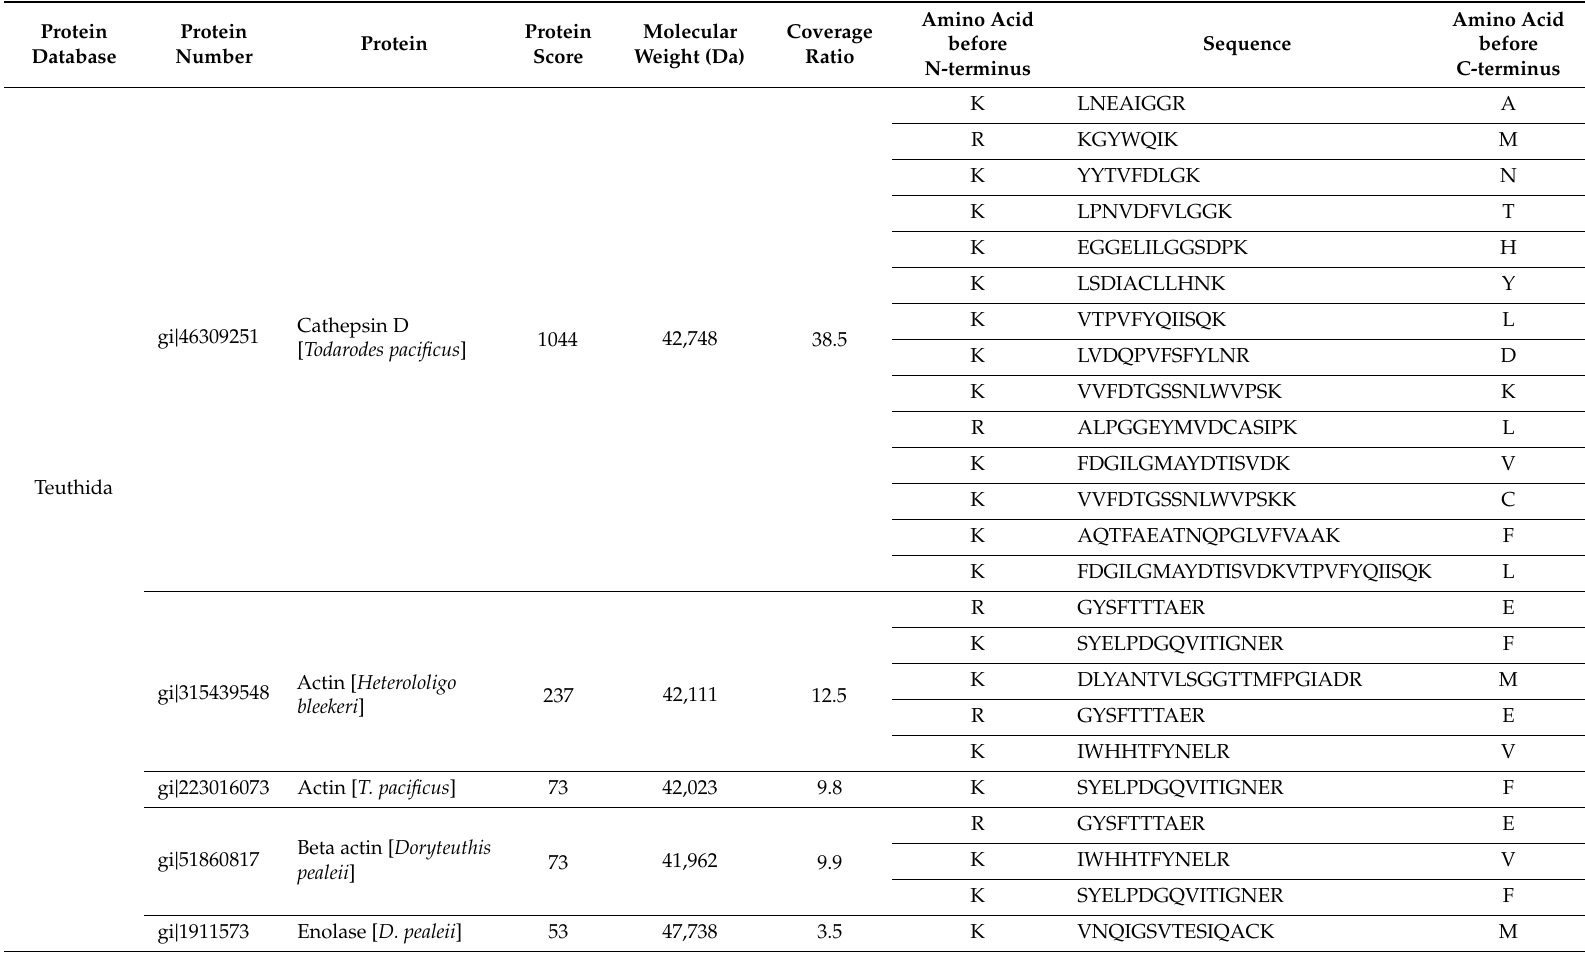
Table 2. Matched peptide sequences of SVCE3(f) trypsin digest with protein database in